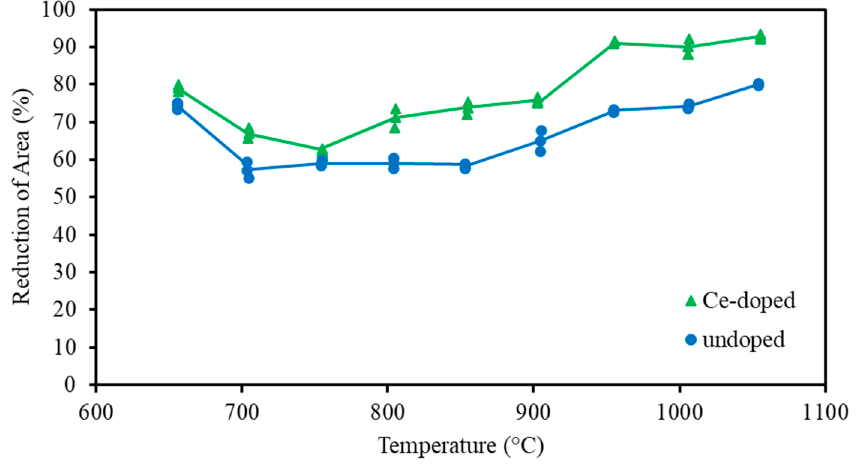
Figure 15. The hot ductility curves of reactor pressure-vessel steel that is both un-doped and doped with 0.07% Ce. The base composition of the steel was 0.18% C, 0.22% Si, 1.45% Mn, 0.75% Ni, and 0.5% Mo [89]. Adapted from [89], with permission from Elsevier,